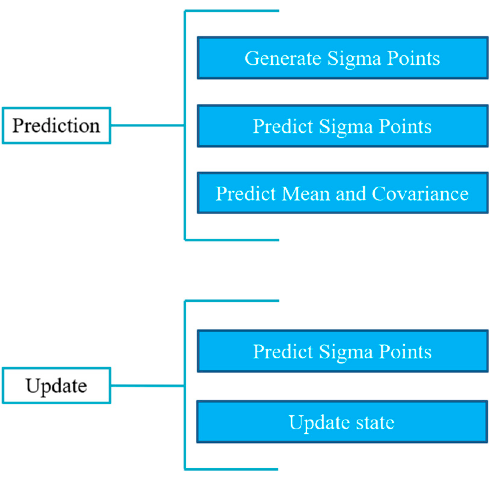
Figure 7. The process of unscented transformation.